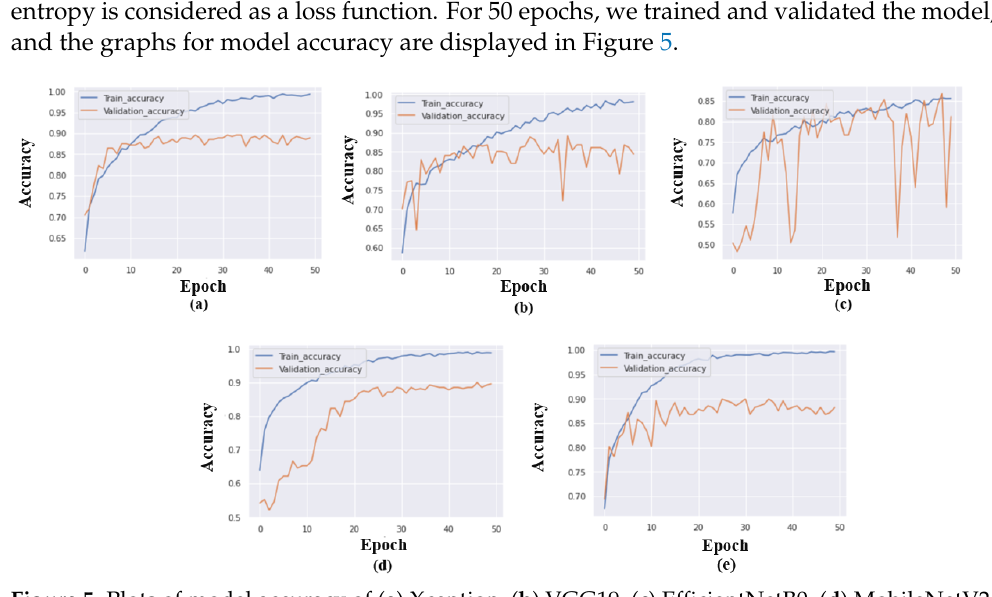
Figure 5. Plots of model accuracy of ( a ) Xception, ( b ) VGG19, ( c ) EfficientNetB0, ( d ) MobileNetV2, and ( e ) Resnet50V2 following each epoch applied to both training and validation set.